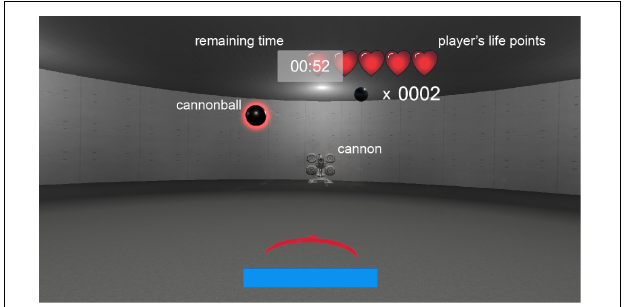
FIGURE 1 | Screenshot of the virtual reality (VR) shooting game. Participants were instructed to shoot down cannonballs using a handgun in a VR